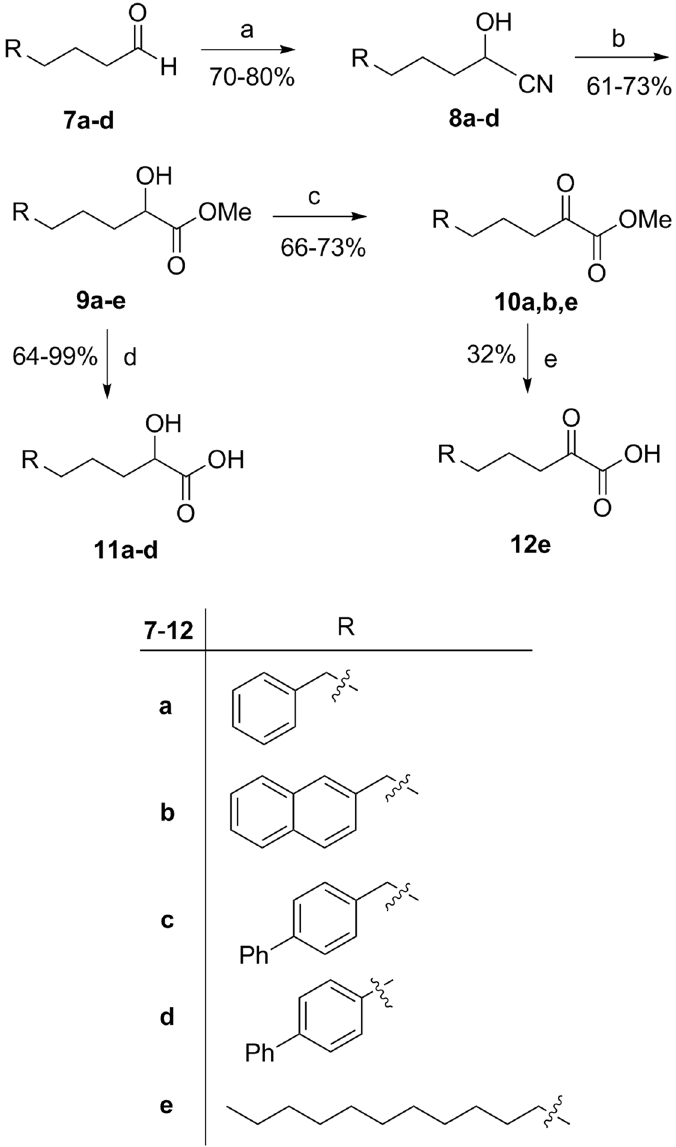
Figure 3. Synthesis of 2-hydroxy acids and 2-oxoacids. ( a ) (i) aq. sol. NaHSO 3 , CH 2 Cl 2 , (ii) KCN, H 2 O; ( b ) 4 N HCl/CH 3 OH; ( c ) Dess-Martin periodinane reagent, dry CH 2 Cl 2 ; ( d ) NaOH 1 N, CH 3 OH; ( e ) 20% aq. sol. Cs 2 CO 3 , CH 3